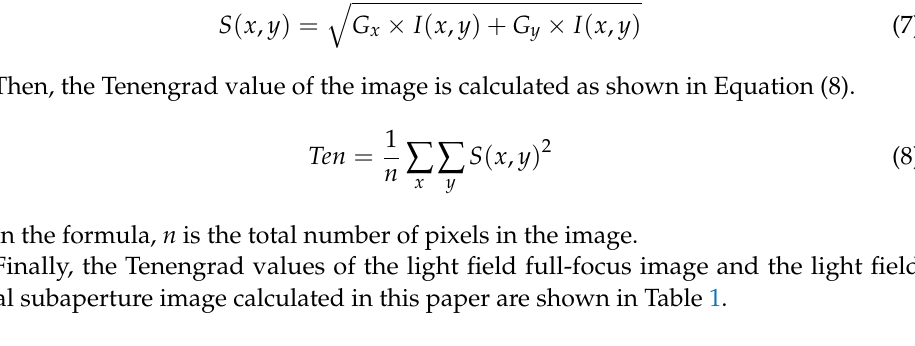
Table 1. Image clarity evaluation Tenengrad value (Retain two decimal